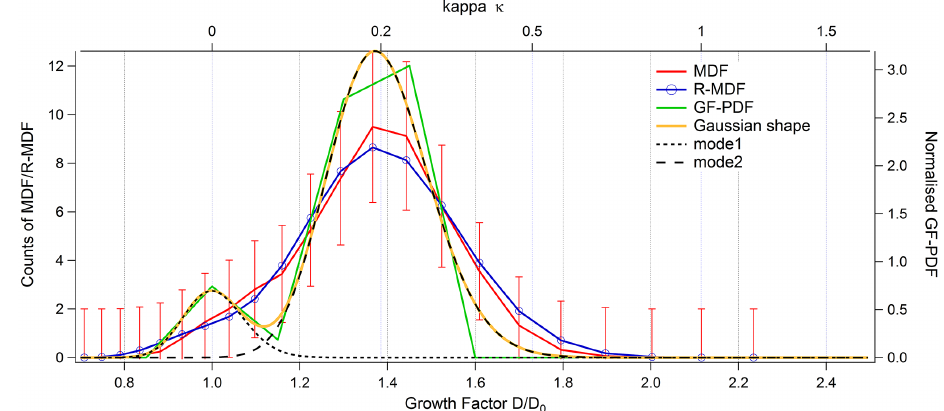
Figure 1. Example of a bimodal growth factor distribution function measured at RH90. The red line refers to measured particle counts, i.e. the MDF (left axis), and the green line is the GF-PDF (right axis). The black dotted lines and the yellow line are the results of super-positioning multiple Gaussians over the GF-PDF obtained from the TDMAinv program (right axis). The bottom axis gives the growth factor GF and the top axis shows the corresponding kappa value κ . Error bars indicate the estimated counting uncertainty of the